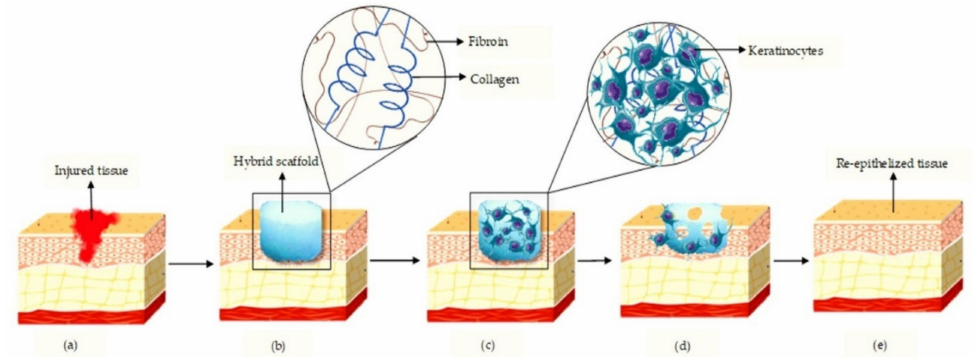
Figure 4. Schematic diagram showing the hybrid action of silk fibroin and collagen in cutaneous healing. ( a ) Injured tissue; ( b ) implant of hybrid sca ff old at the wounded site; ( c ) Adhesion of keratinocytes to the hybrid sca ff old; ( d ) Degradation of the sca ff old; ( e ) Re-epithelised regenerated